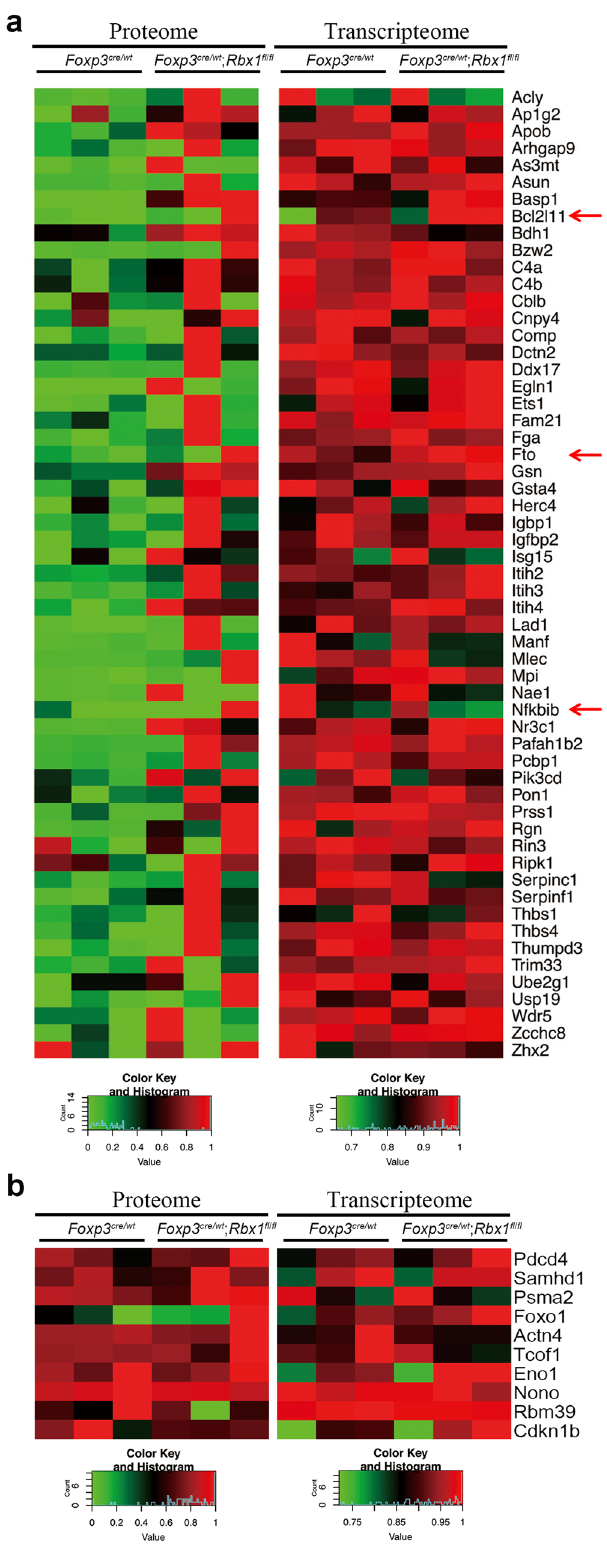
Fig. 5 Comparison of the levels of proteins vs. mRNAs of indicated genes in CD4 + YFP + Treg cells from Foxp3 cre / wt and Foxp3 cre / wt ; Rbx1 fl / fl mice (8 – 10 weeks old). a Comparison of the levels of proteins vs. mRNAs in indicated genes in CD4 + YFP + Treg cells from female Foxp3 cre / wt and Foxp3 cre / wt ; Rbx1 fl / fl mice (8 – 10 weeks old). Those with increased levels of protein but not of mRNA were considered as candidates of the direct degradation substrates of Rbx1 E3 ligase in Treg cells. b Some common substrates of Rbx1 are not accumulated in Rbx1-de fi cient Treg